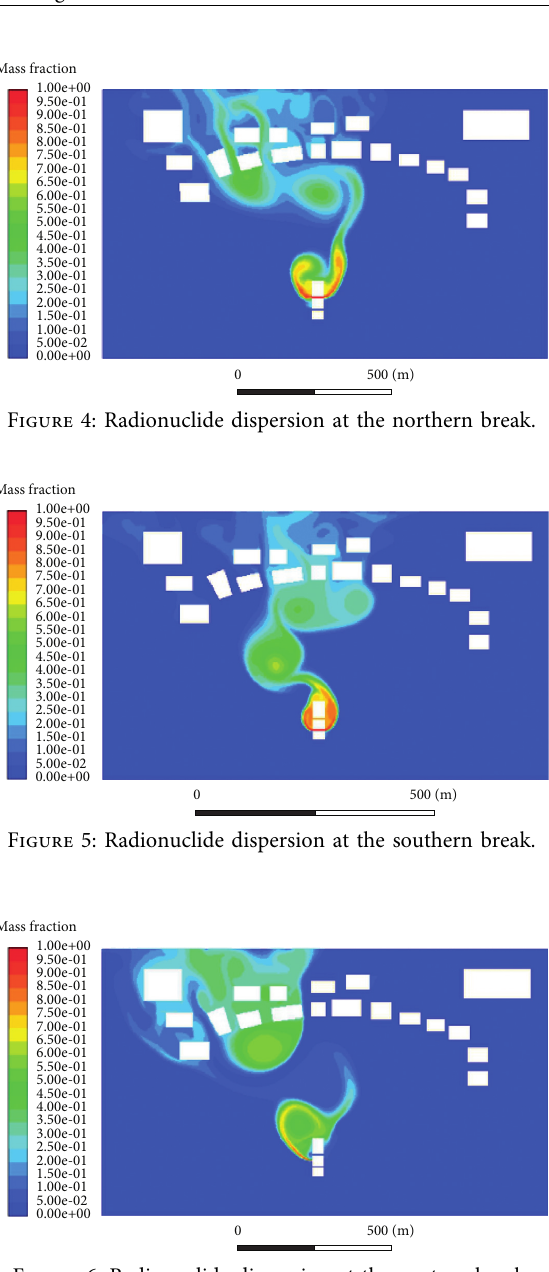
Table 1: Environmental release share of various radionuclides. Radionuclide Xe